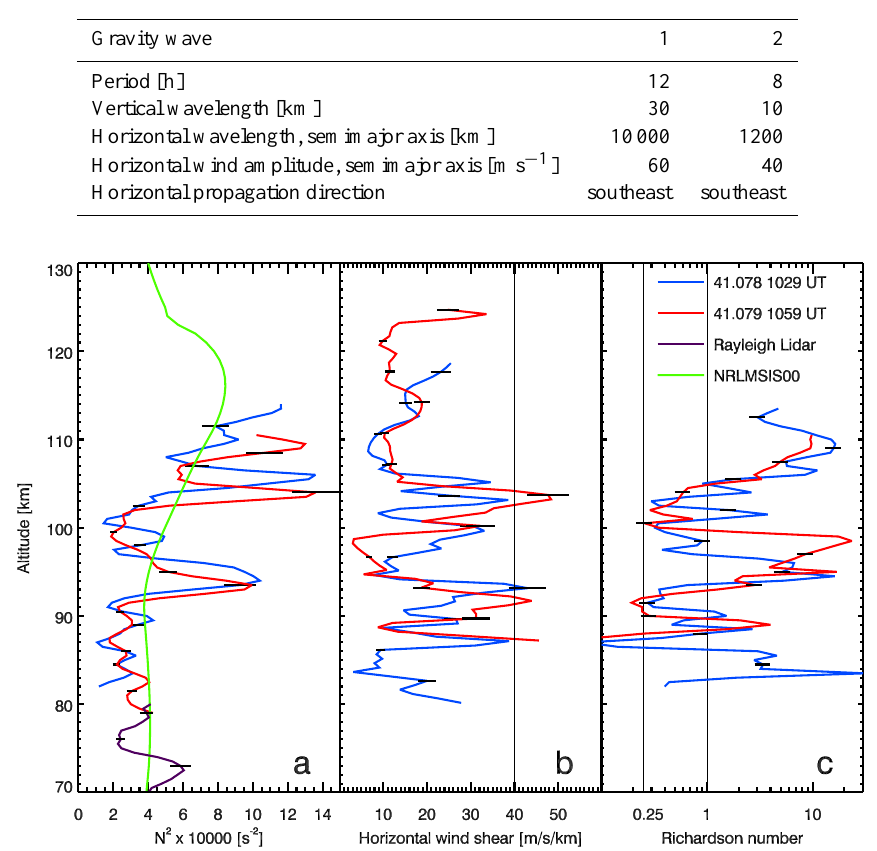
Fig. 5. (a) Brunt-Vais¨al¨a frequency squared calculated from rocket and lidar temperatures, (b) wind shear from TMA winds, (c) Richardson number where observations